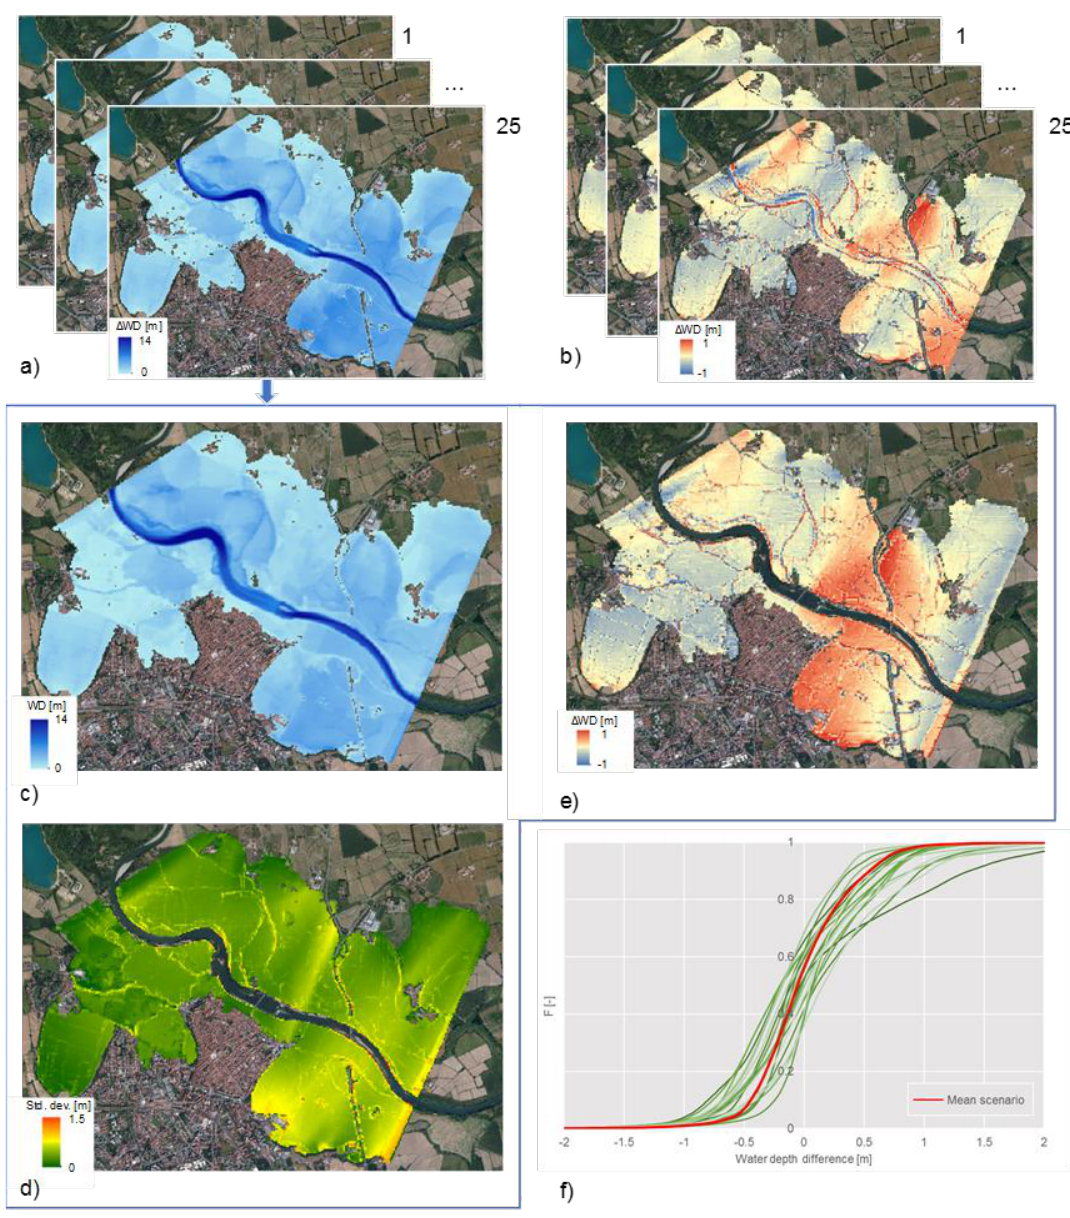
Figure 8. Sensitivity analysis of RAPIDE results to the location of auxiliary lines: ( a ) Water depth maps for the 25 tested configurations; ( b ) ∆ WD maps for 25 tested configurations; ( c ) Water depth map for the ‘mean scenario’; ( d ) Map of standard deviations of water depth for the ‘mean scenario’; ( e ) ∆ WD maps for the ‘mean scenario’; ( f ) Cumulative density functions of ∆ WD for the 25 considered configurations (green lines) and the ‘mean scenario’ (red line).